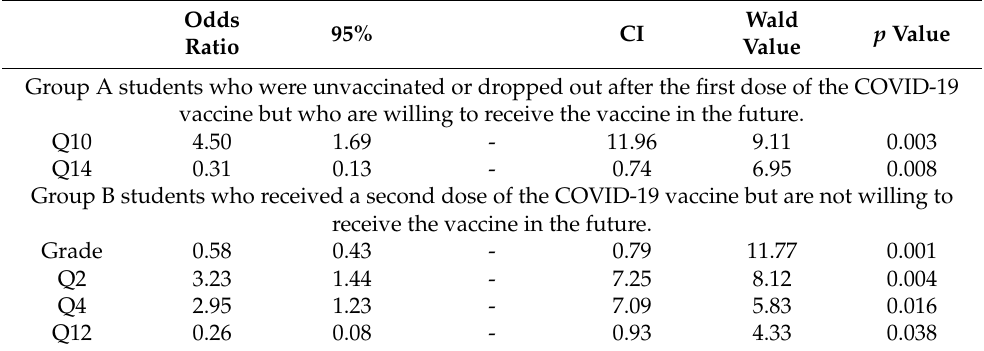
Wald p Value Value